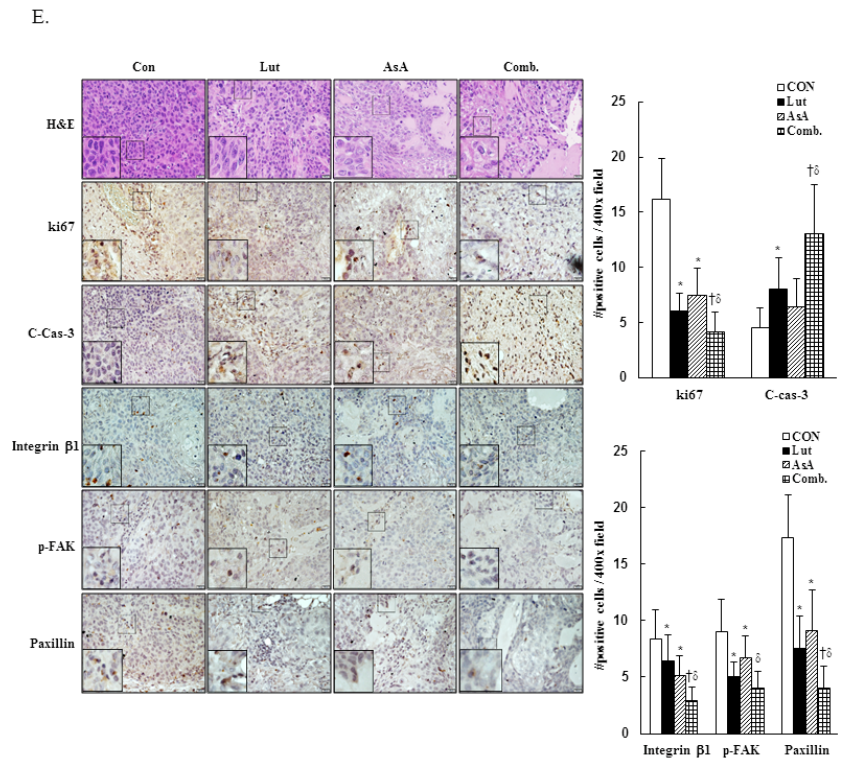
Figure 9. Luteolin combined with asiatic acid suppressed tumor growth and tumor weight increase in BALB/c nude mice. CaSki cells (1 × 10 7 cells) were injected subcutaneously into the right flank of nude mice. Treatment was initiated 6 days after CaSki cell injection; Lut (50 mg/kg) or AsA (100 mg/kg), in combination or vehicle control alone (10% DMSO) was injected intraperitoneally every day. ( A ) Schematic representation of the experiment. ( B ) Representative images of tumors. ( C ) Tumor volume and body weight were measured every two days. ( D ) Tumor weight was recorded after sacrifice on day 22. ( E ) Representative histological sections of the tumor tissue were stained with hematoxylin and eosin, ki67, caspase-3, integrin β 1, p-FAK and paxillin (shown as brown staining; H&E, 200x, bar = 50 μ m; IHC, 400×, bar = 20 μ m). Quantitative results are shown in the lower plot. Values represent mean ± SD ( n = 6/group). *, † and δ p < 0.05 compared with CON, Lut- or AsA- treated groups. CON, control; Lut, luteolin; AsA, asiatic acid; Comb., luteolin combined with asiatic acid.